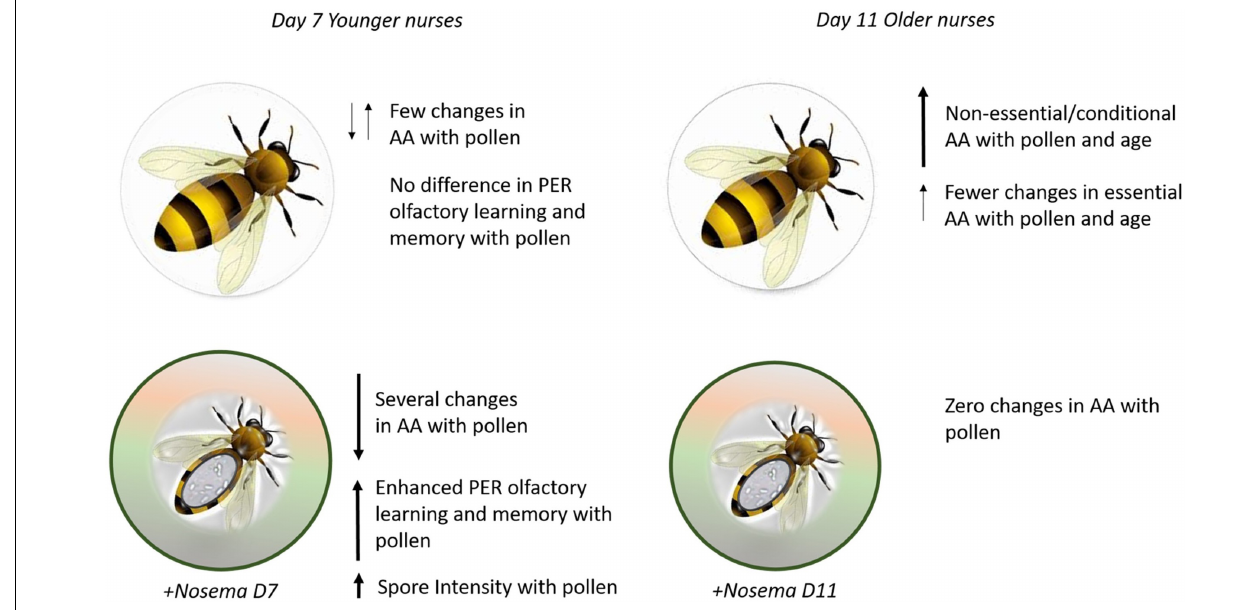
Frontiers in Neuroscience |